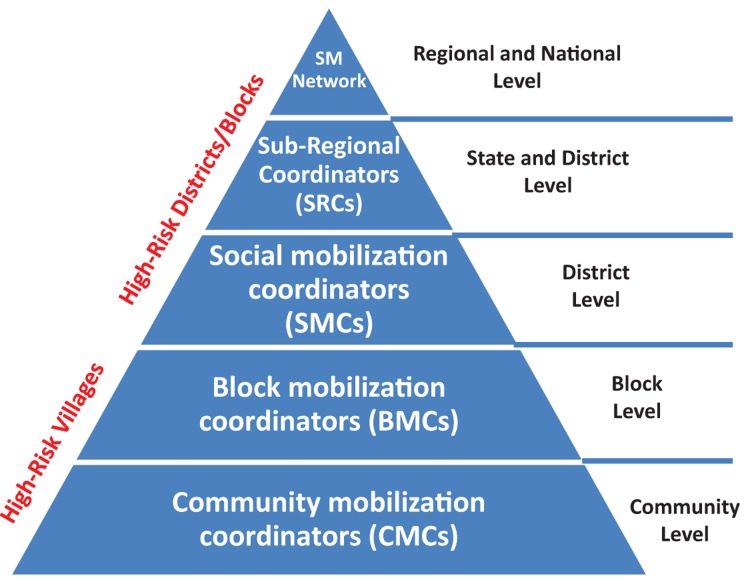
Social Mobilization Network (SMNet) PyramidSource: Reference 10.